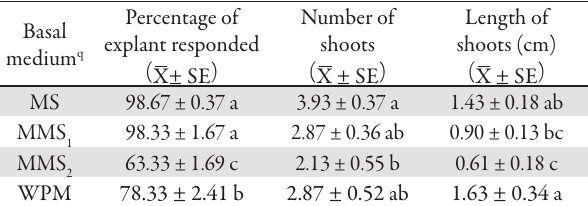
Tab. 2. Effects of different basal media containing 4 µM BA